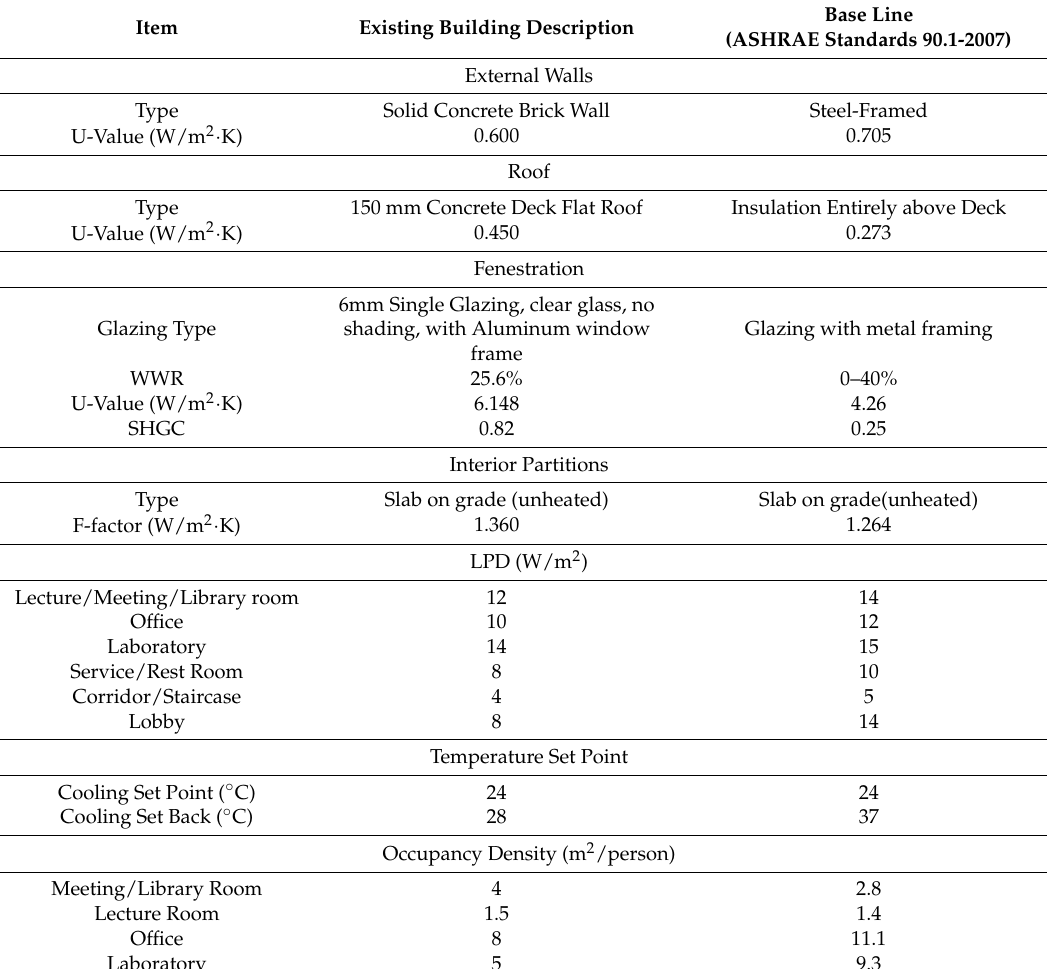
Table 5. CYC building construction and services information.